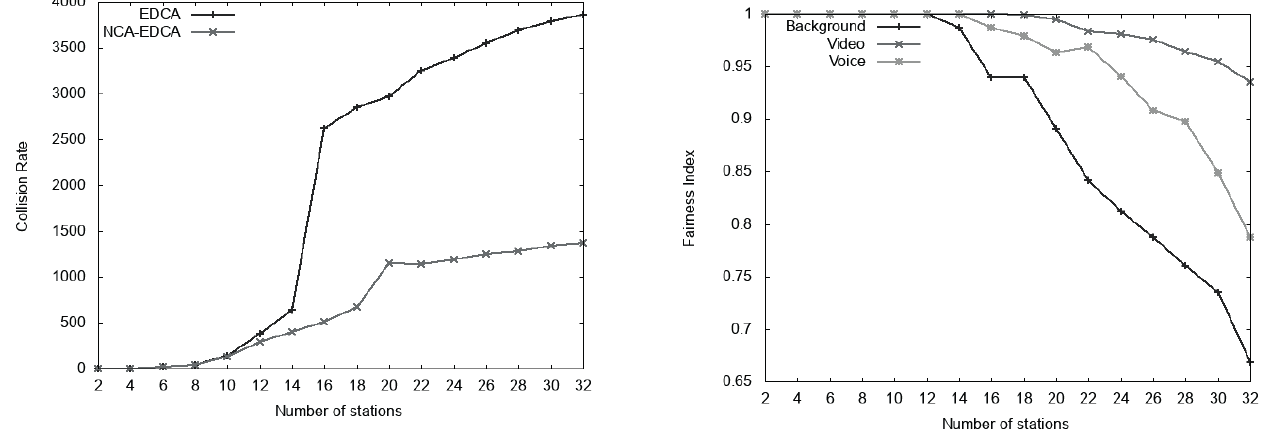
Fig. 13. Fairness of